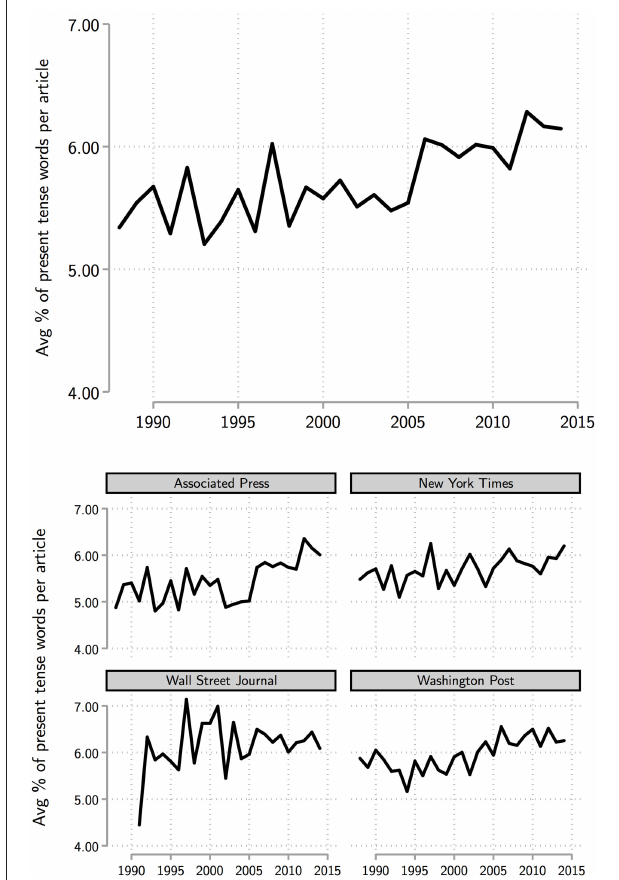
FIGURE 5 | Frequency of present-tense related language in climate change news coverage from 1988 to 2014 in our combined corpus (top panel) and by source (bottom